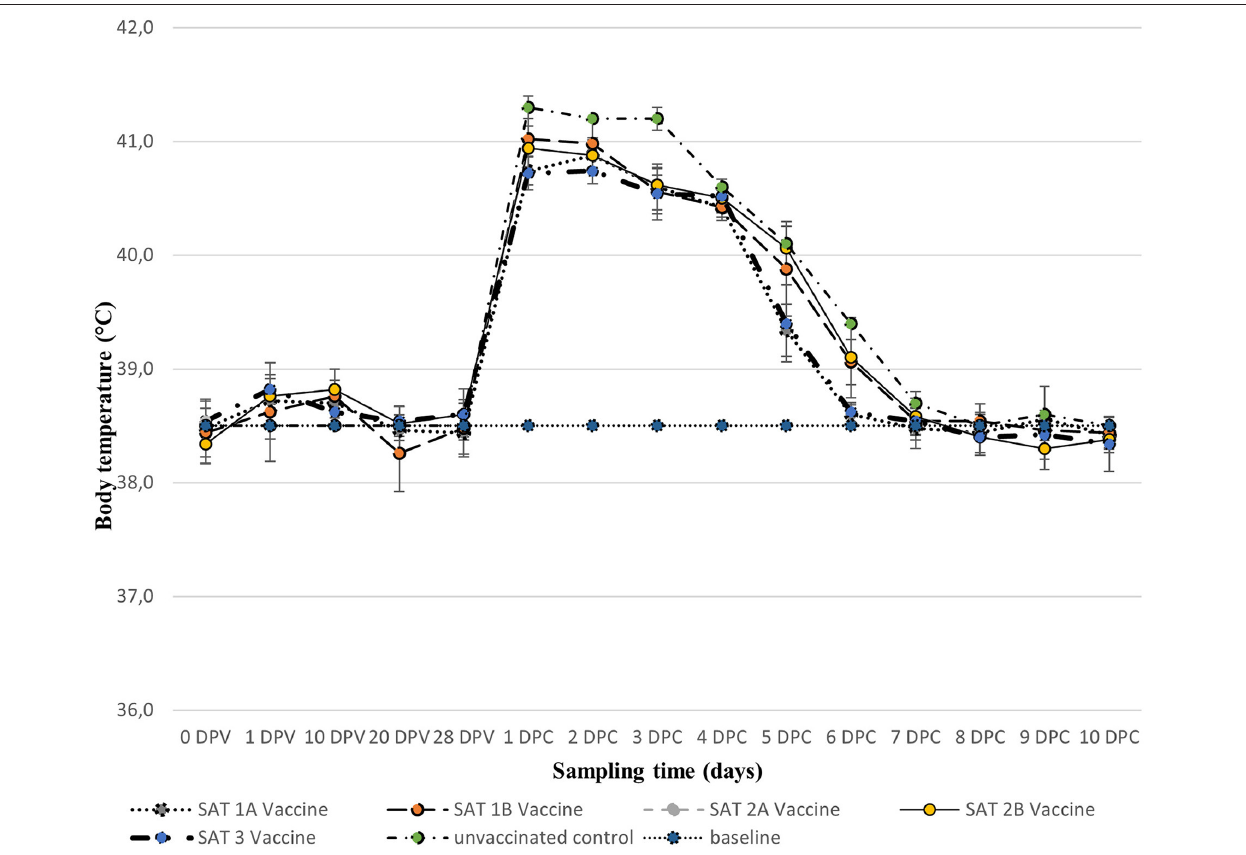
FIGURE 1 | Mean ( ± SD) rectal body temperatures ( ◦ C) of groups of animals vaccinated with 2 ml of the five monovalent vaccines [0–28 days post-vaccination (dpv)] and after respective homologous virus challenge [1–10 days post-challenge (dpc)]. The horizontal dotted line represents the baseline temperature (38.5 ◦ C).